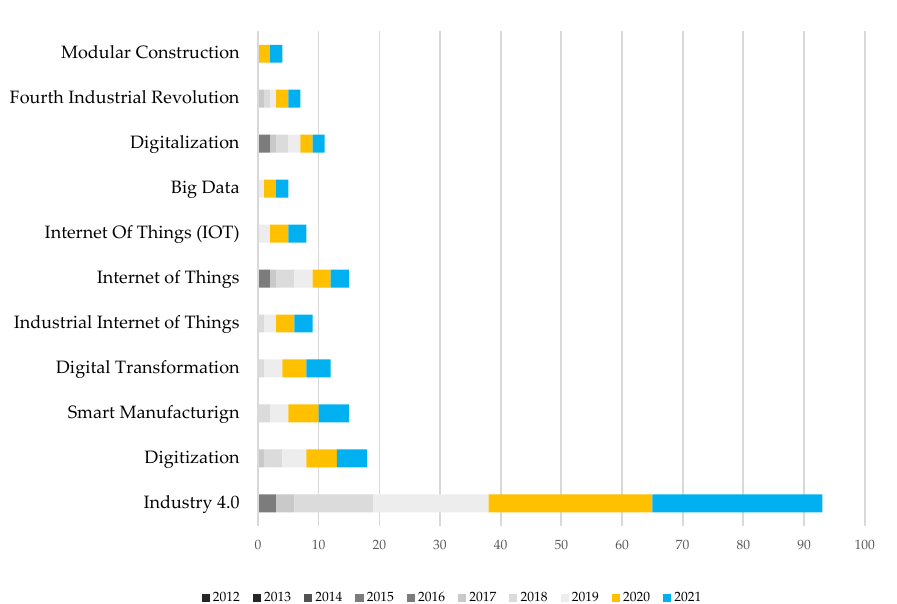
Figure 4. The most dramatic increases in the use of “Industry 4.0” coincide with the global outbreak of COVID-19.